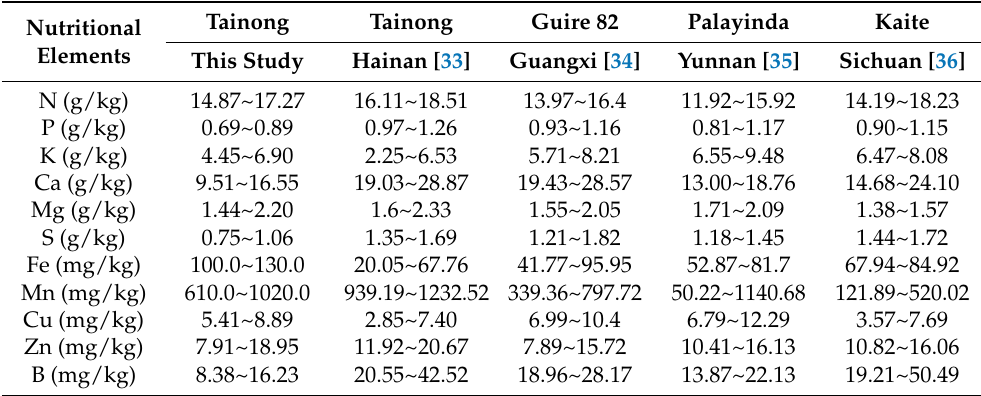
Table 6. The appropriate values for leaf nutrient diagnosis during the reproductive growth period of different varieties of mangoes in different